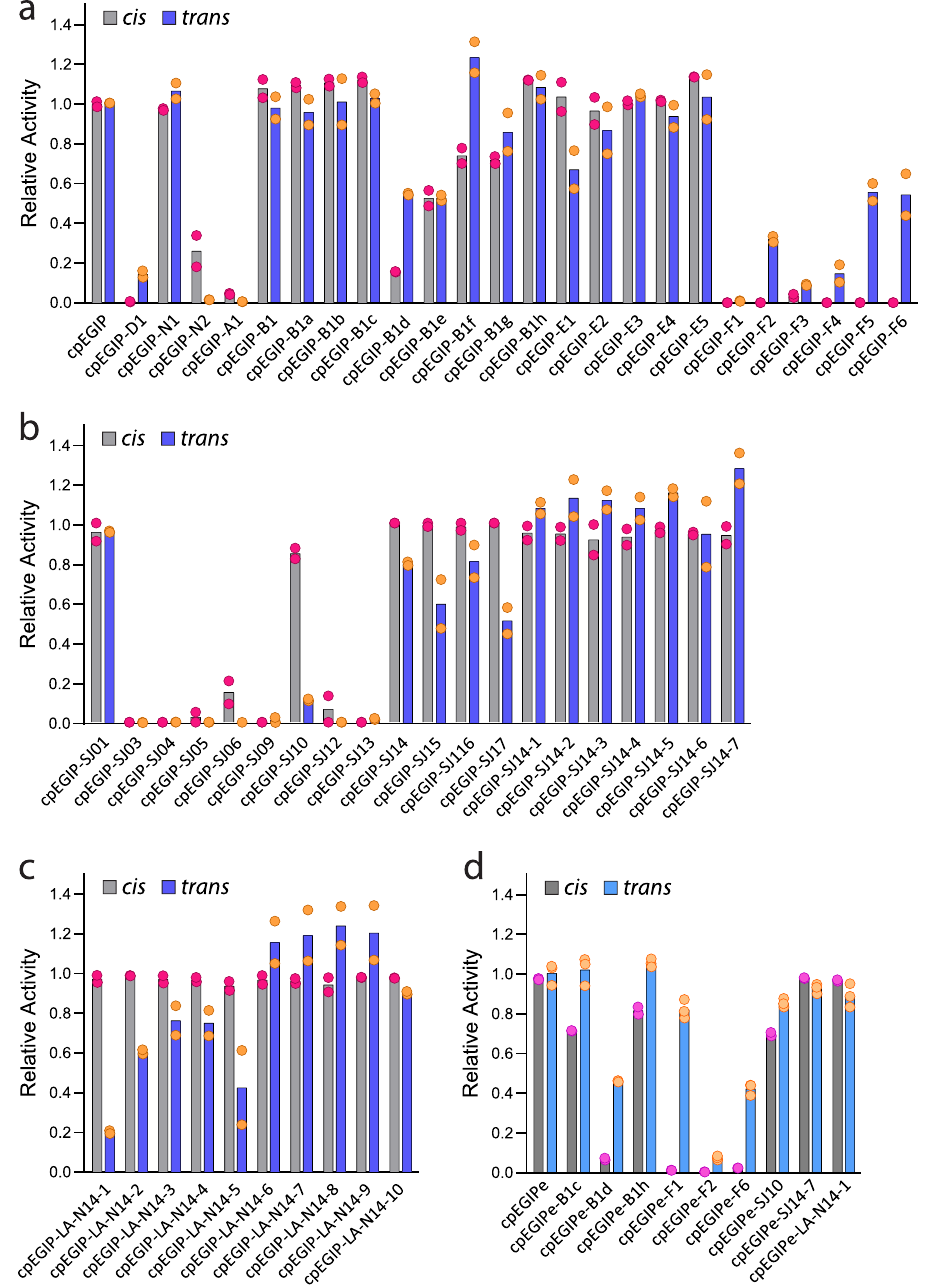
Fig. 5 Chemical modi fi cation of the As Cas12a crRNA 5 ′ handle modulates non-sequence-speci fi c trans ssDNase activity. a – d Comparing dsDNA sequence-speci fi c cis and ssDNA non-speci fi c trans activity of As Cas12a with crRNAs containing modi fi ed 5 ′ handles. Error bars are standard deviation and replicates are biological. The guide sequence used in panels ( a – c ) (cpEGIP) is designed to target an EGFP-containing plasmid for in vitro cis cleavage while the guide used in panel ( d ) (cpEGIPe) is designed to target a chromosomally integrated EGFP gene for cell-based editing. For all samples, two separate replicates were performed ( n = 2). Source data are provided as a Source Data fi